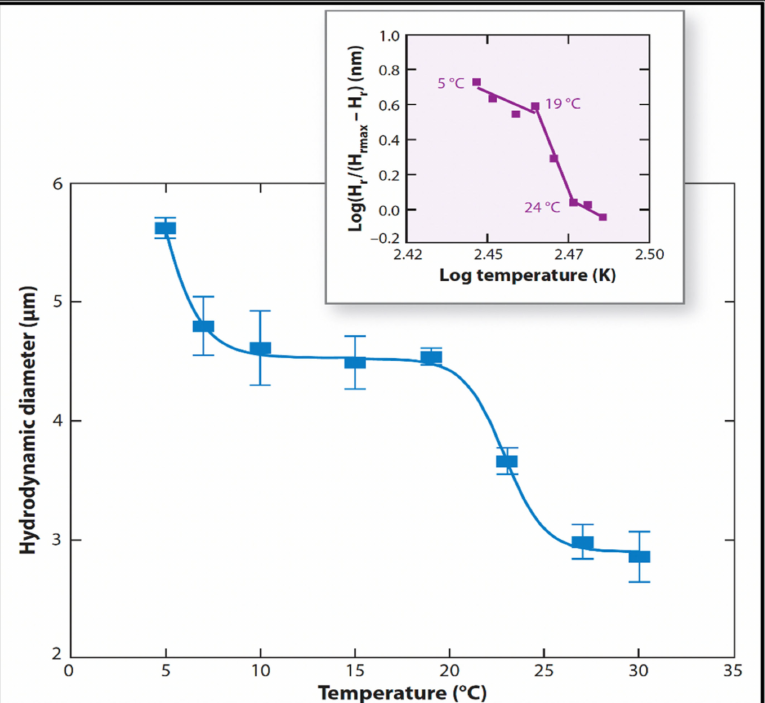
Figure 19. Measurements of MG hydrodynamic diameter by Photon Correlation Spectroscopy show that MG exhibits a two-step temperature-induced phase transition, with critical points at ~7 ◦ C and between 20 ◦ C and 25 ◦ C. Inset. The Hill coefficients in both cases exhibit values that portray the typical high cooperativity of critical phenomena. Each point corresponds to the average ± SD. of five